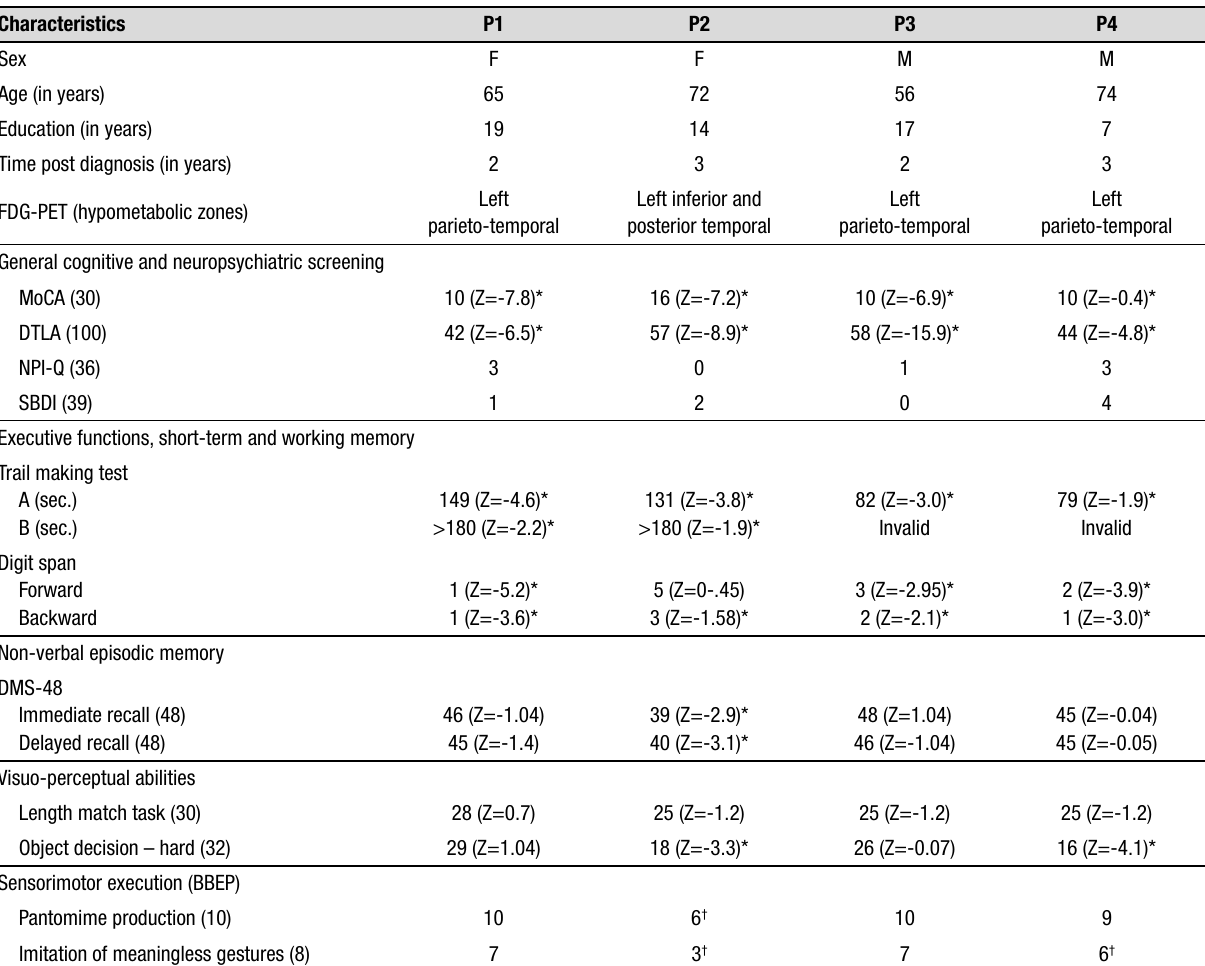
Table 1. Participants’ demographic data and results on clinical and neuropsychological tests